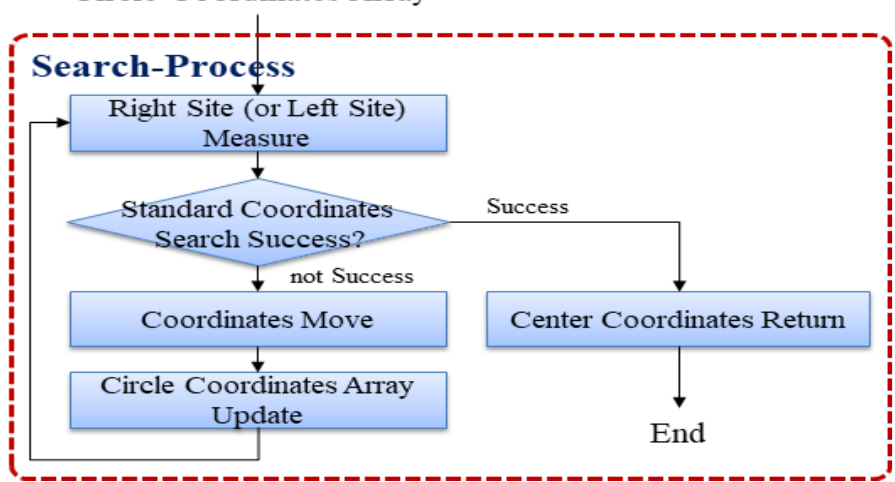
Figure 11. Starting point search process.